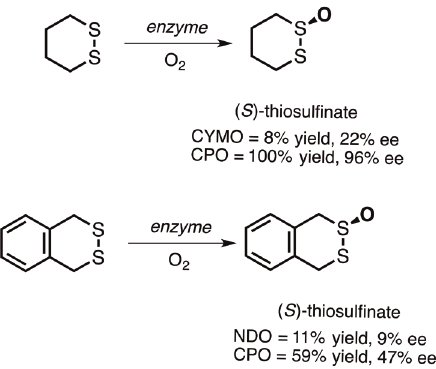
Figure 26 - Thiosulfinates obtained by sulfoxidation of 1,2-disulfides.